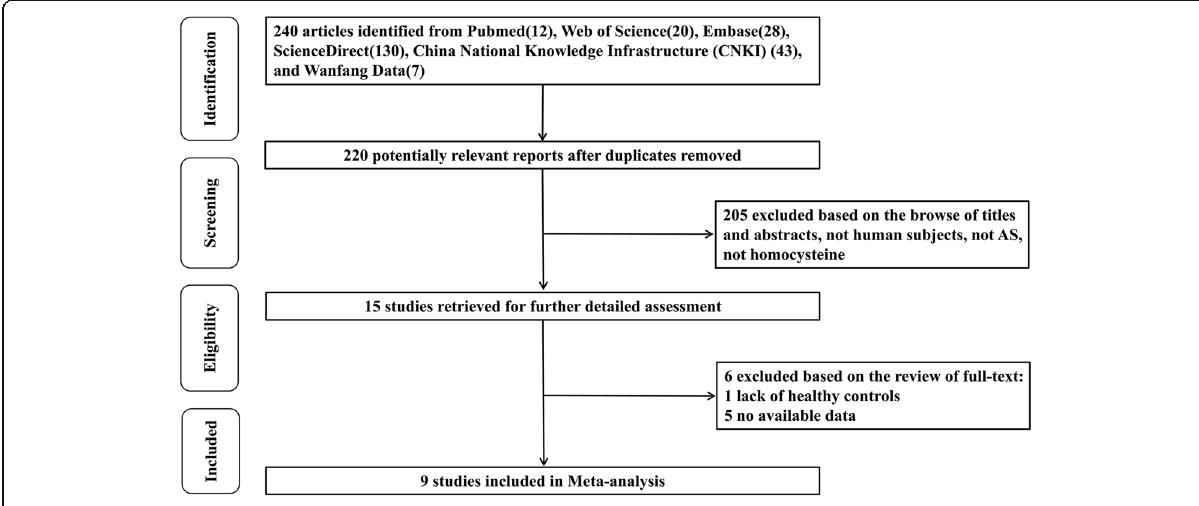
Fig. 1 Flow chart of selected